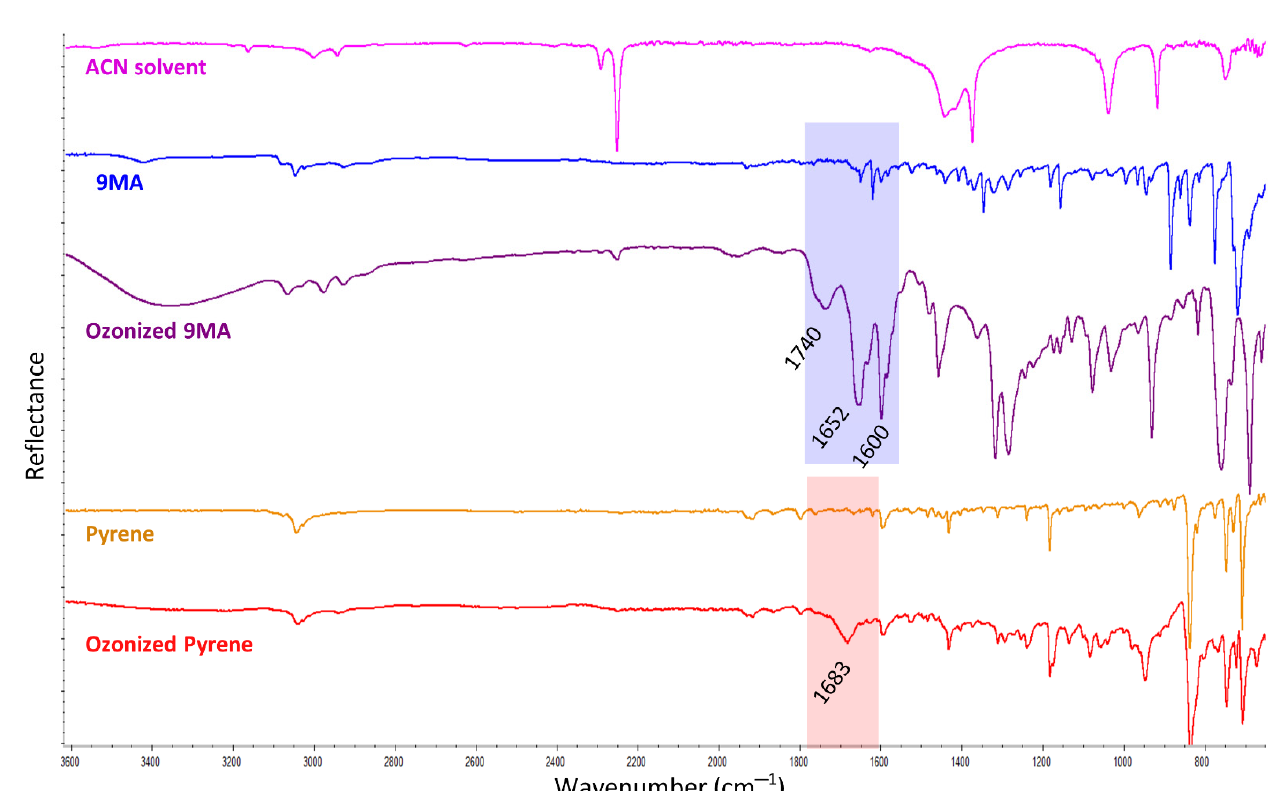
Figure 1. FTIR spectra of the 9-methylantracene (9MA) and pyrene standards in acetonitrile solutions (after the solvent evaporation on the ATR), and after 60 min of ozone treatment in the homogeneous experiments (also after the solvent evaporation on the ATR). The acetonitrile solvent (ACN) spectrum is also displayed as reference. The FTIR spectra are vertically offset for clarity.